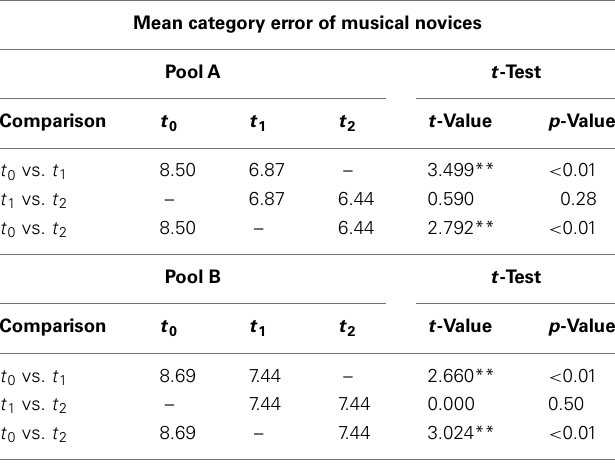
Table 2 | “Improvements of tonal categorization in musical novices.” Mean category error of musical